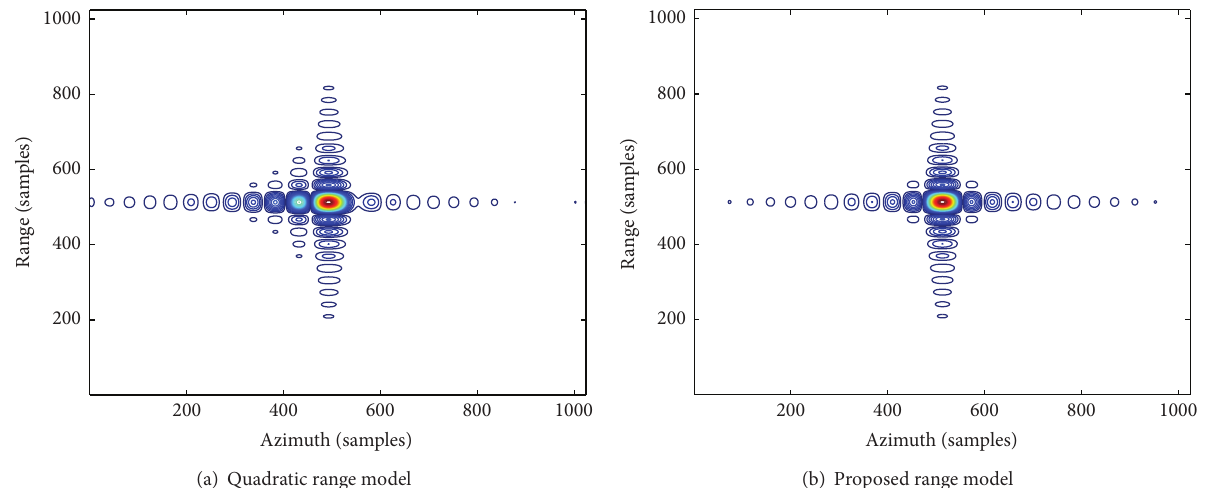
Figure 5: Contour plots comparison using different range